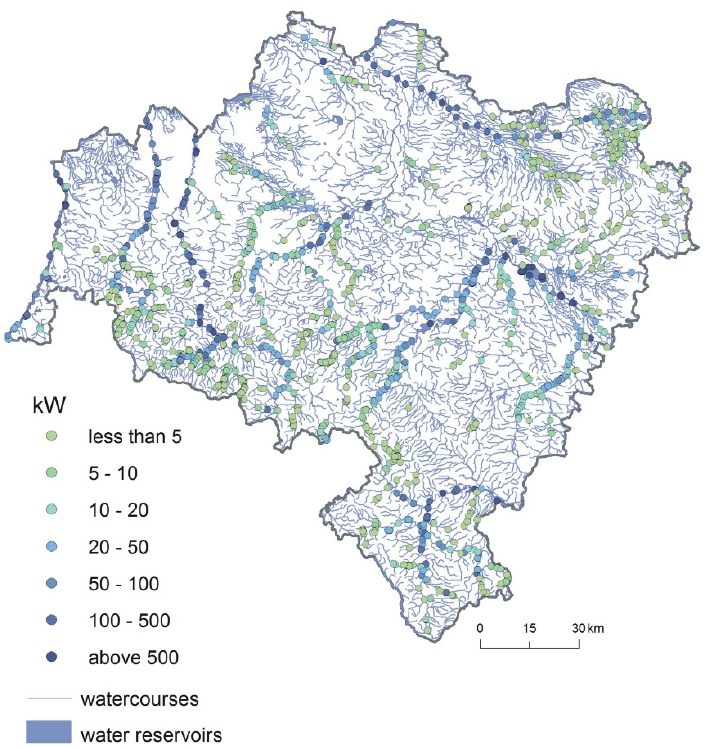
Figure 6. Localization of water dams and power of the potential hydropower plants in the Dolno ś l ą skie voivodeship (own elaboration). The power of all the potential hydropower plants in Kujawsko-Pomorskie voivodeship on dams is 95.2 MW (Figure 7) is 28.6 MW.